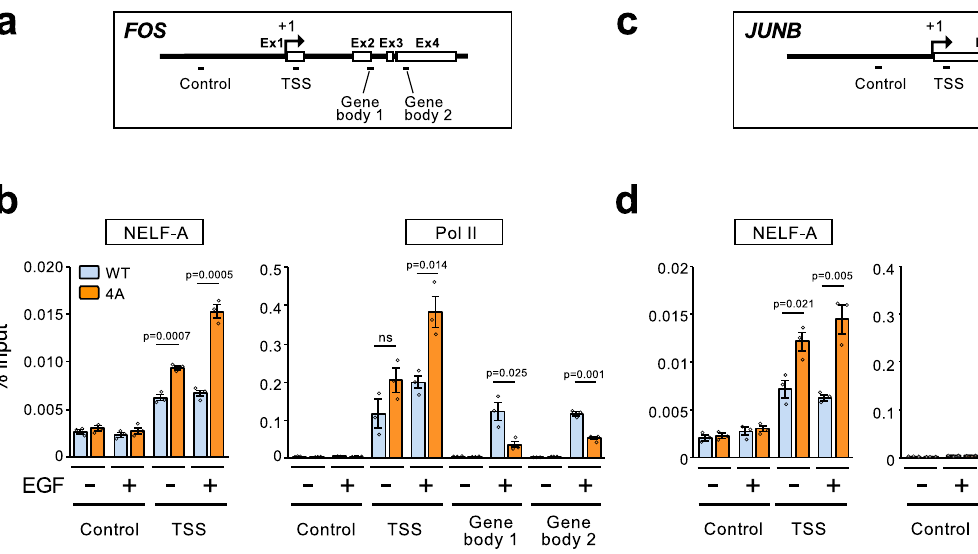
Fig. 4 | ERK-mediated NELF-A phosphorylation promotes transcriptional elongation of IEGs. a , c Schematic diagrams of the FOS ( a ) and JUNB ( c ) genomic loci. Boxes represent exons and bars below the genes show the positions of amplicons used for ChIP-qPCR analyses. TSS, transcription start site. b , d Distribution of NELF-A and RNApolymerase II (Pol-II) on the FOS ( b ) and JUNB ( d )genesbeforeandafterEGFstimulation.ChIP-qPCRassayswereperformedwith